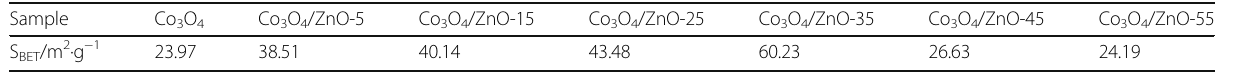
Table 2 BET specific surface areas of pure Co 3 O 4 nanoparticles and Co 3 O 4 /ZnO heterostructures